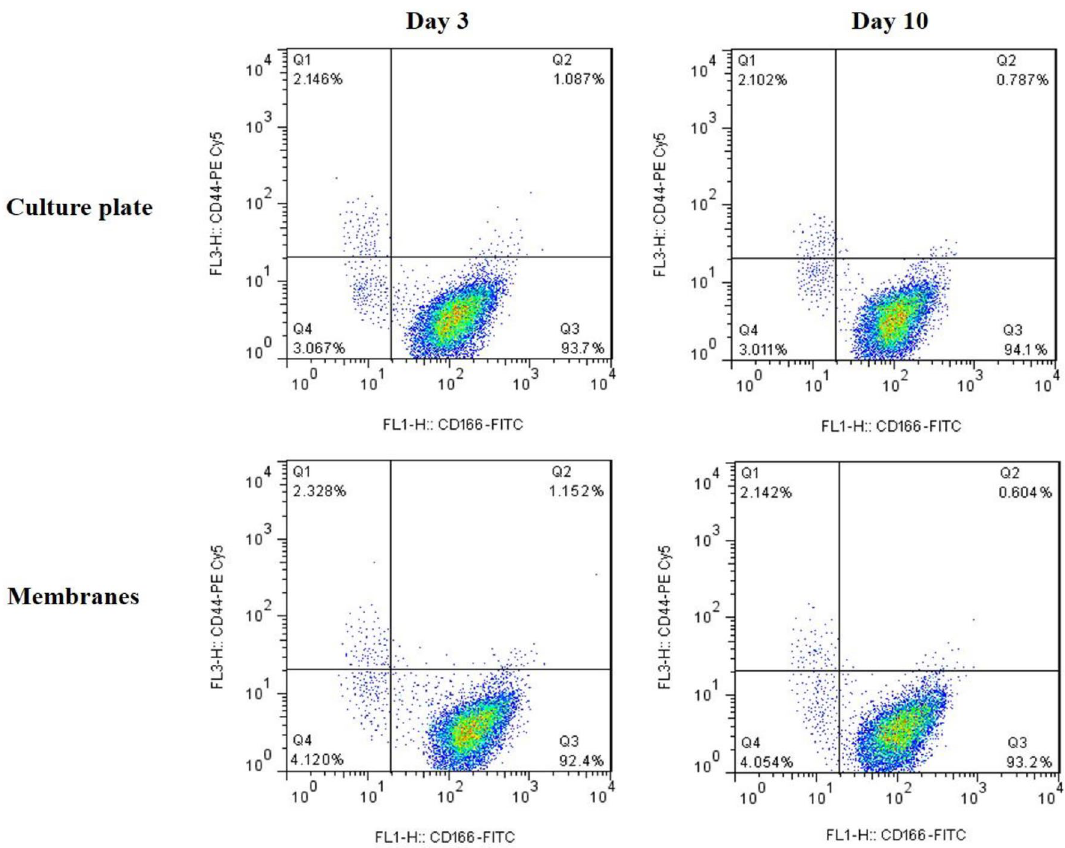
Figure 8. Flow cytometer analysis of CD166 and CD44 expression during culture period by HCECs cultured on culture plate (control) and CSNPs/PCL 50/25 membrane after 3 and 10 days.